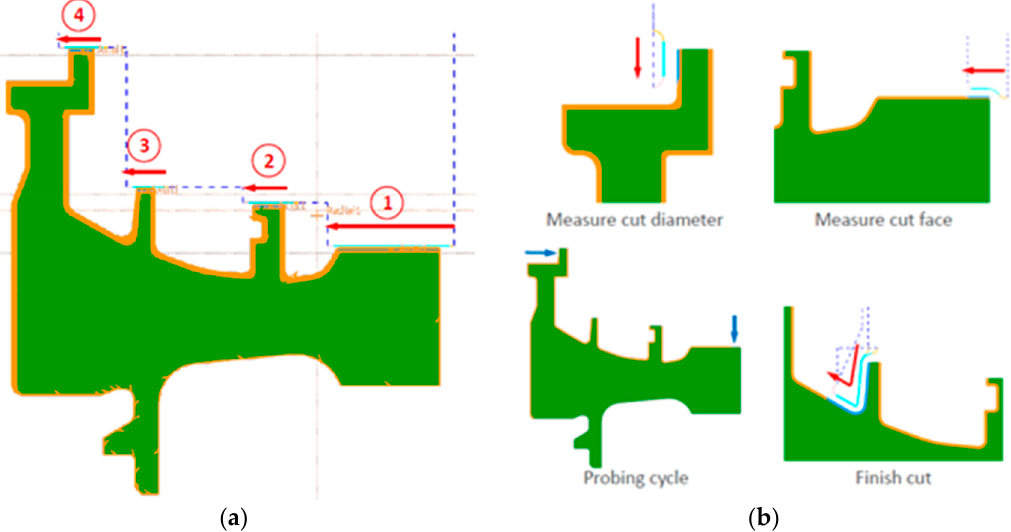
Figure 3. The tool paths by simulation results: ( a ) stage A at semi-finishing; ( b ) stage J at finishing. Table 3. The information on cutting conditions and machining time. ( a ) Semi-finishing; ( b ) finishing. (a)